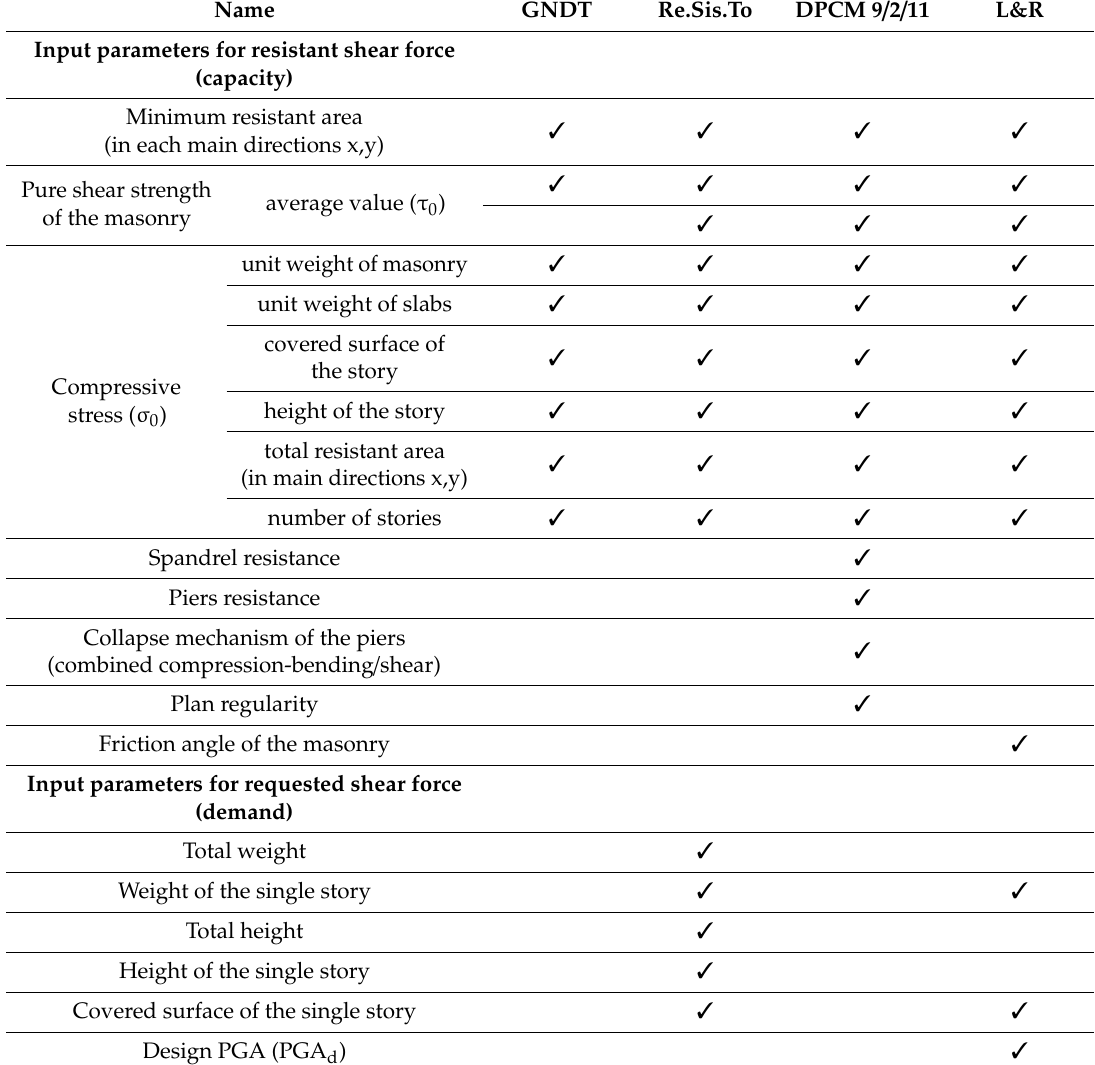
Table 3. Methods of Group B for masonry buildings: input parameters for maximum and resistant shear